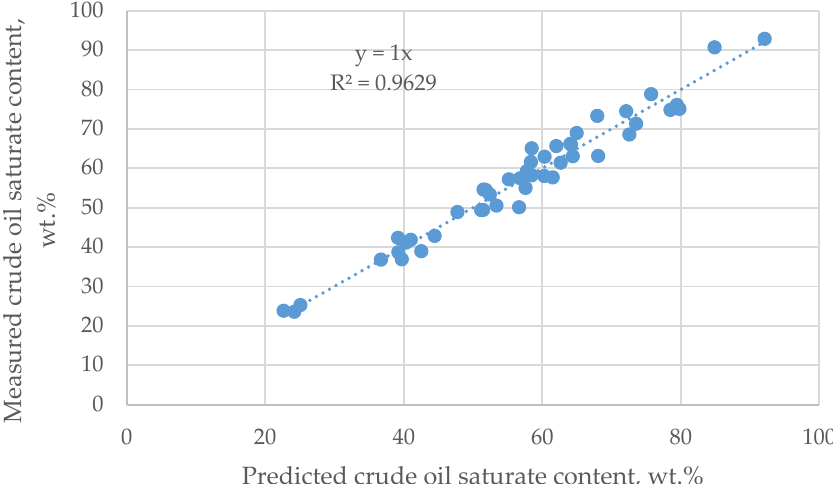
Figure 9. Parity graphs of measured crude oil saturate content versus crude oil saturate content predicted with Equation (10) ( a ) and Equation (11) ( b ).